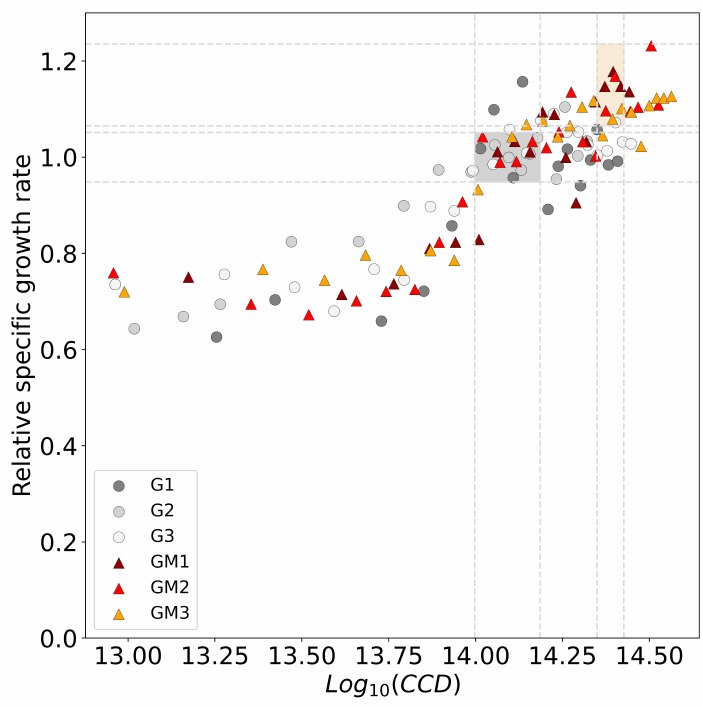
Figure 5. The relative fitness of replicate ALE experiments with E. coli K12 MG1655 growing with the non-native carbon source glycerol. Relative fitness is defined as the stable specific growth rate divided by the average stable specific growth rate of the control group of WT E. coli without NTG. The cumulative number of cell divisions (CCD) is used as time scale to measure adaptation progress. The specific growth rate is considered stable if the moving average of three consecutive batches has an absolute standard deviation < 0.01 h − 1 and no further upwards trend. This definition of a stable phenotype is specific to this set of experiments. A decisive criterion was required to make near-real-time decisions while the experiment was running; hence, a variability based approach was chosen that focuses on the change in optimization metric: the specific growth rate. The specific growth rate of the stable phenotype of the E. coli wild-type cultures without NTG is 0.61 ± 0.03 h − 1 at a log 10 ( CCD ) = 14.09 ± 0.09 and is used to compare both groups and calculate the relative fitness (grey shaded area, relative fitness of the WT = 1 ± 0.05). The observed average specific growth rate of the WT strain with NTG is 0.70 ± 0.05 h − 1 and was reached at a log 10 ( CCD ) = 14.39 ± 0.04 (orange shaded area, relative fitness of the WT with NTG = 1.15 ±